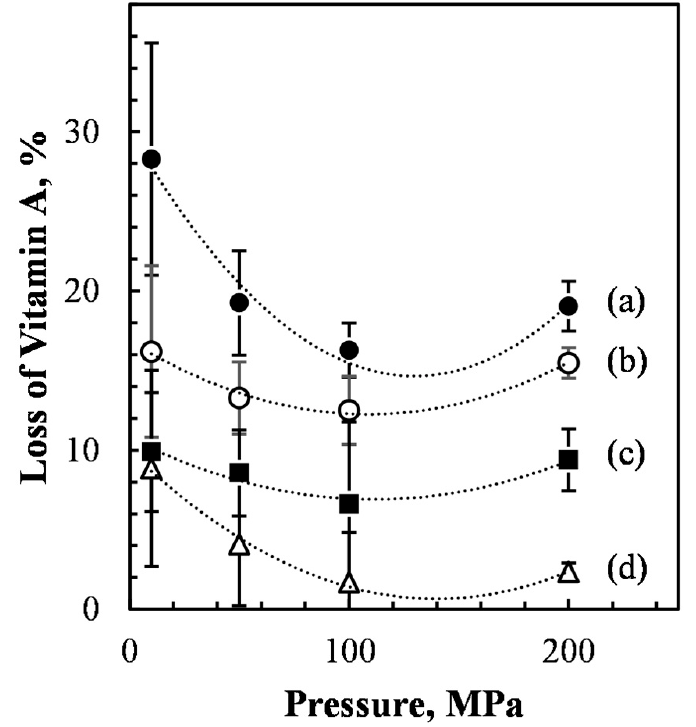
Figure 4. Effect of the applied pressure on the percentage loss of vitamin A, measured just after the microfluidization step compared to the coarse emulsion before microfluidizer process, for samples containing increasing concentrations of α -tocopherol: ( a ); 0 mg/g; ( b ) 0.25 mg/g; ( c ) 0.50 mg/g; ( d ) 1.00 mg/g.